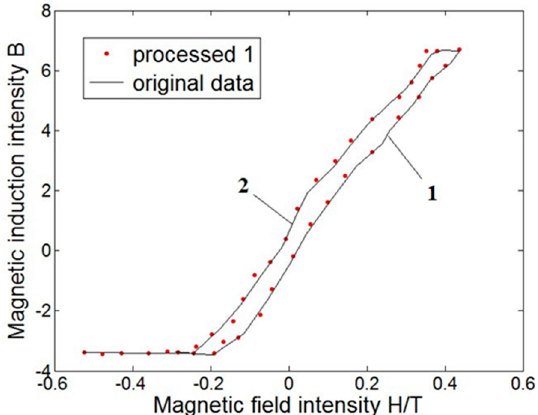
Figure 3. Fitting curve and original experimental data curve. ”Processed 1” represents the fitting curve through least squares method. ”Original data” represents the original experimental data.